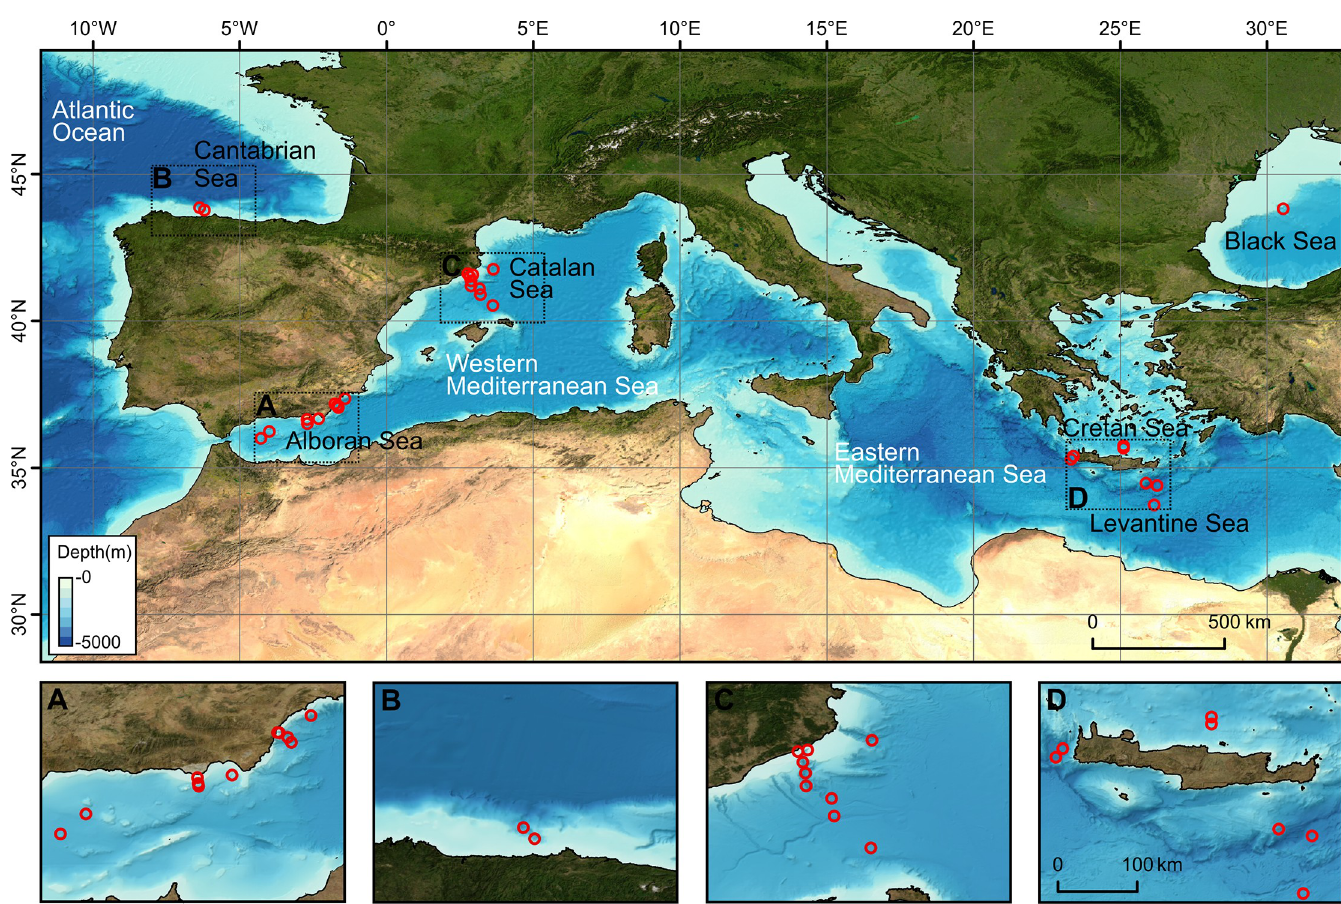
Fig 1. General map of the southern European seas. The location of surface sediment sampling stations for the analysis of plastic fibres is shown as red open circles. Black boxes mark areas that are shown as zoom-ins below. The map was generated using the GEBCO_2014 grid (http://www.gebco.net/data_and_products/gridded_ bathymetry_data/) and ArcGIS version 10.3 (http://desktop.arcgis.com/en/arcmap/).